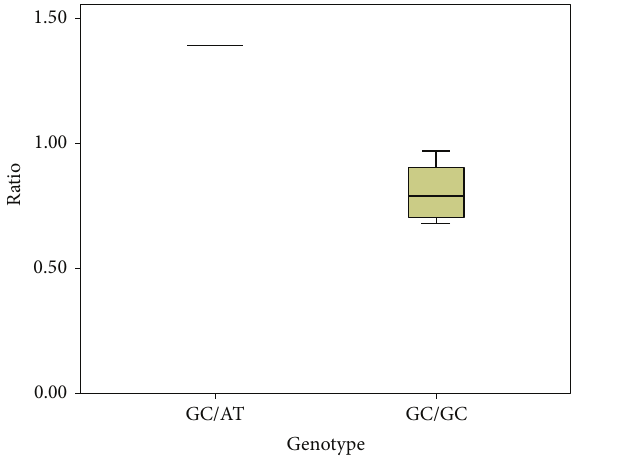
Figure 3: Relative TAp73/ Δ Np73 protein isoform ratios in can- cer cell line lysates with GC/GC and GC/AT genotype. The TAp73/ Δ Np73 protein isoform levels were determined from the western blotting data in Figures 2(a) and 2(b). These p73 protein isoform levels were used to calculate the relative ratio values reported in Table 3. The mean of TAp73/ Δ Np73 protein isoform ratio values is box-plotted.